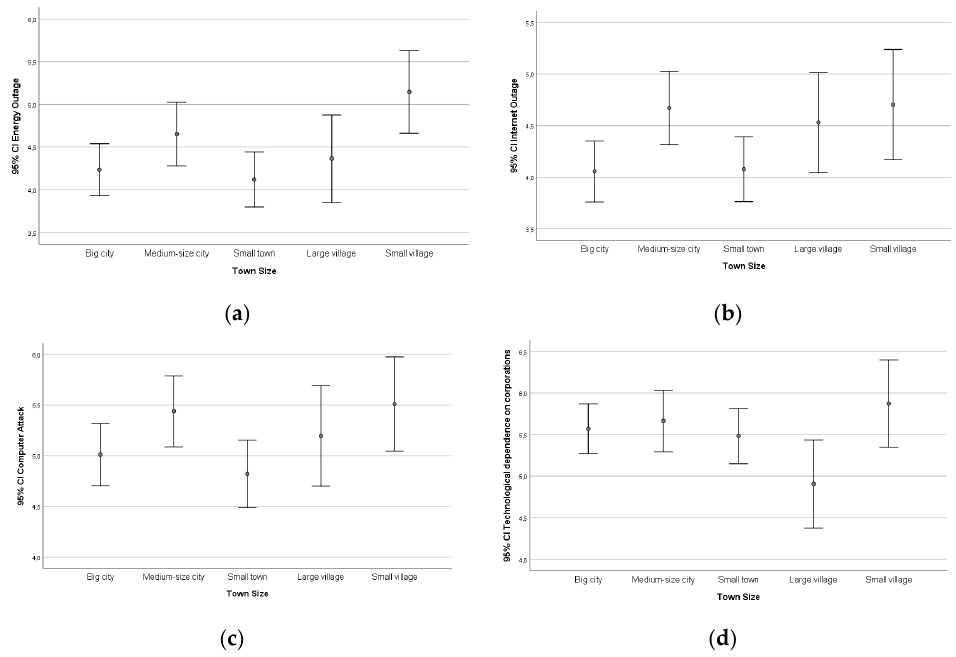
Figure 1. The perceived dangers with respect to the subjective town size. Means and confidence intervals. ( a ) Means and 95% confidence intervals for energy outage versus town size; ( b ) means and 95% confidence intervals for Internet outage versus town size; ( c ) means and 95% confidence intervals for computer attack versus town size; and ( d ) means and 95% confidence intervals for technological dependence versus town size. Source: Own results.